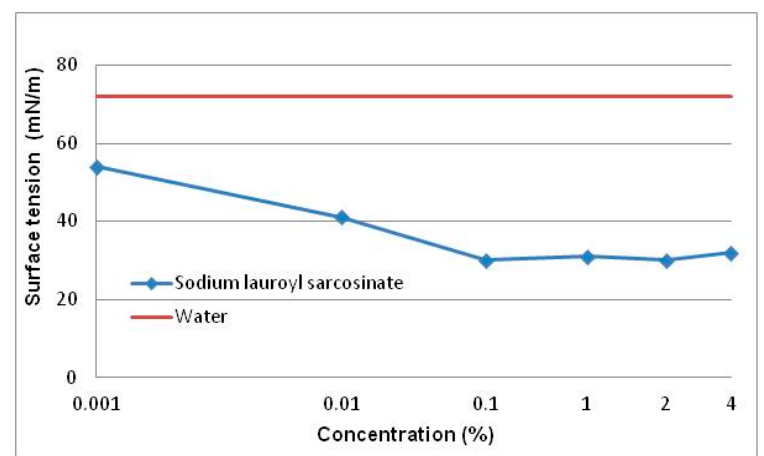
Figure 5. Surface tension of aqueous solutions of sodium lauroyl sarcosinate as a function of its concentration. Measurement temperature ca. 20 °C, Lauda tensiometer. Solid line describes the σ value for water (72 mN/m).